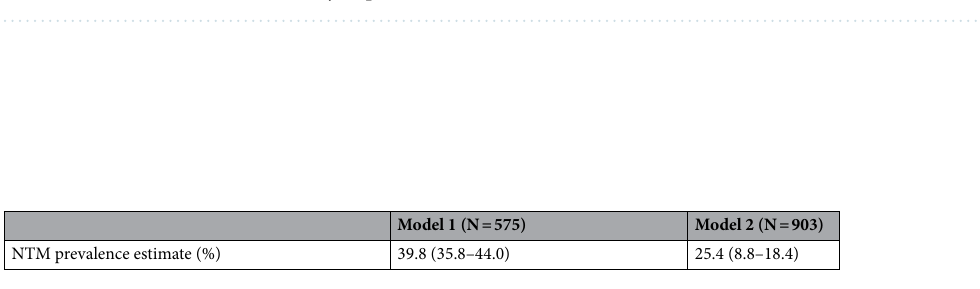
Table 1. Characteristics of the Study Population (n = 575).